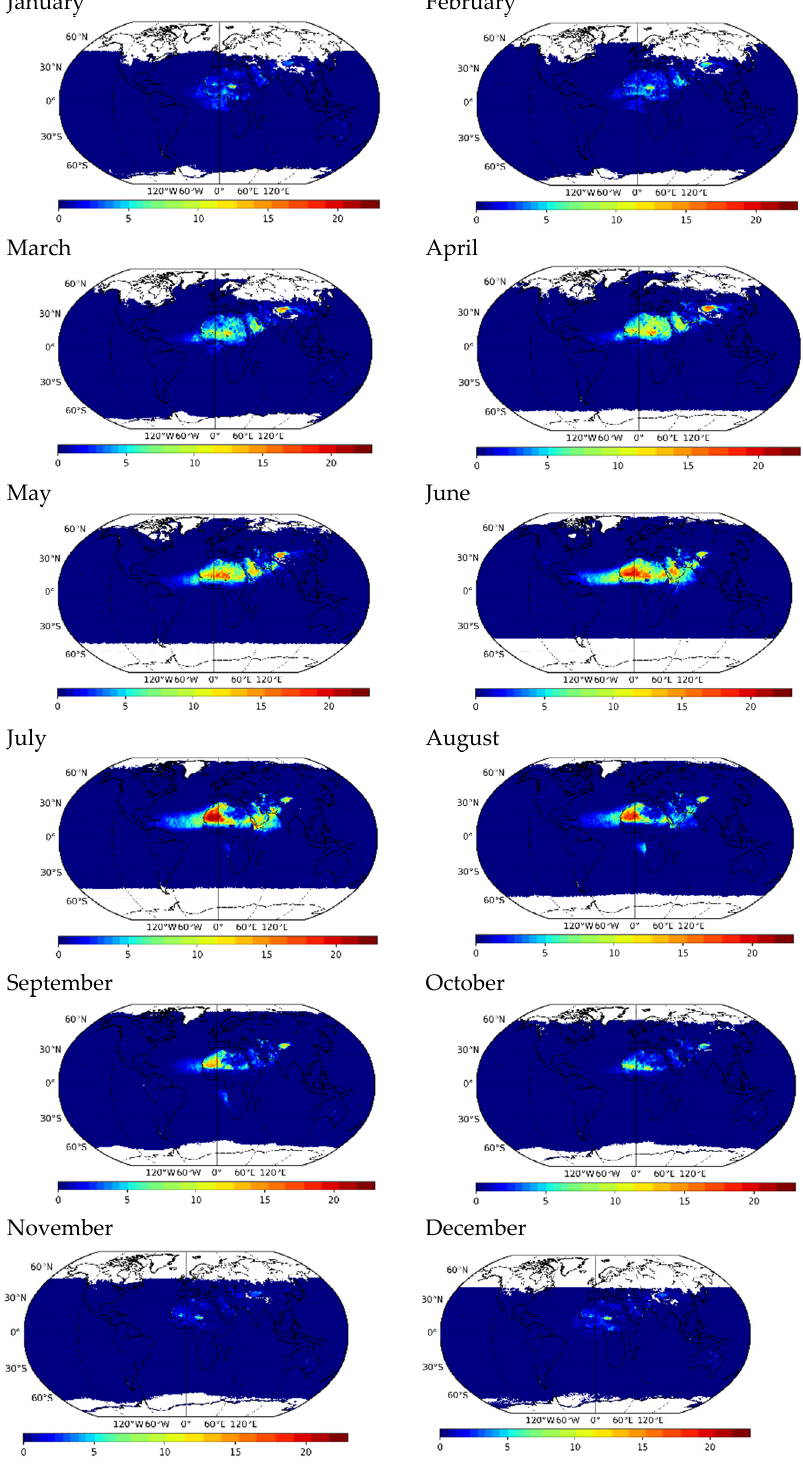
Figure 4. Global distribution of the monthly absolute frequency of occurrence of dust aerosols (in number of days/month).